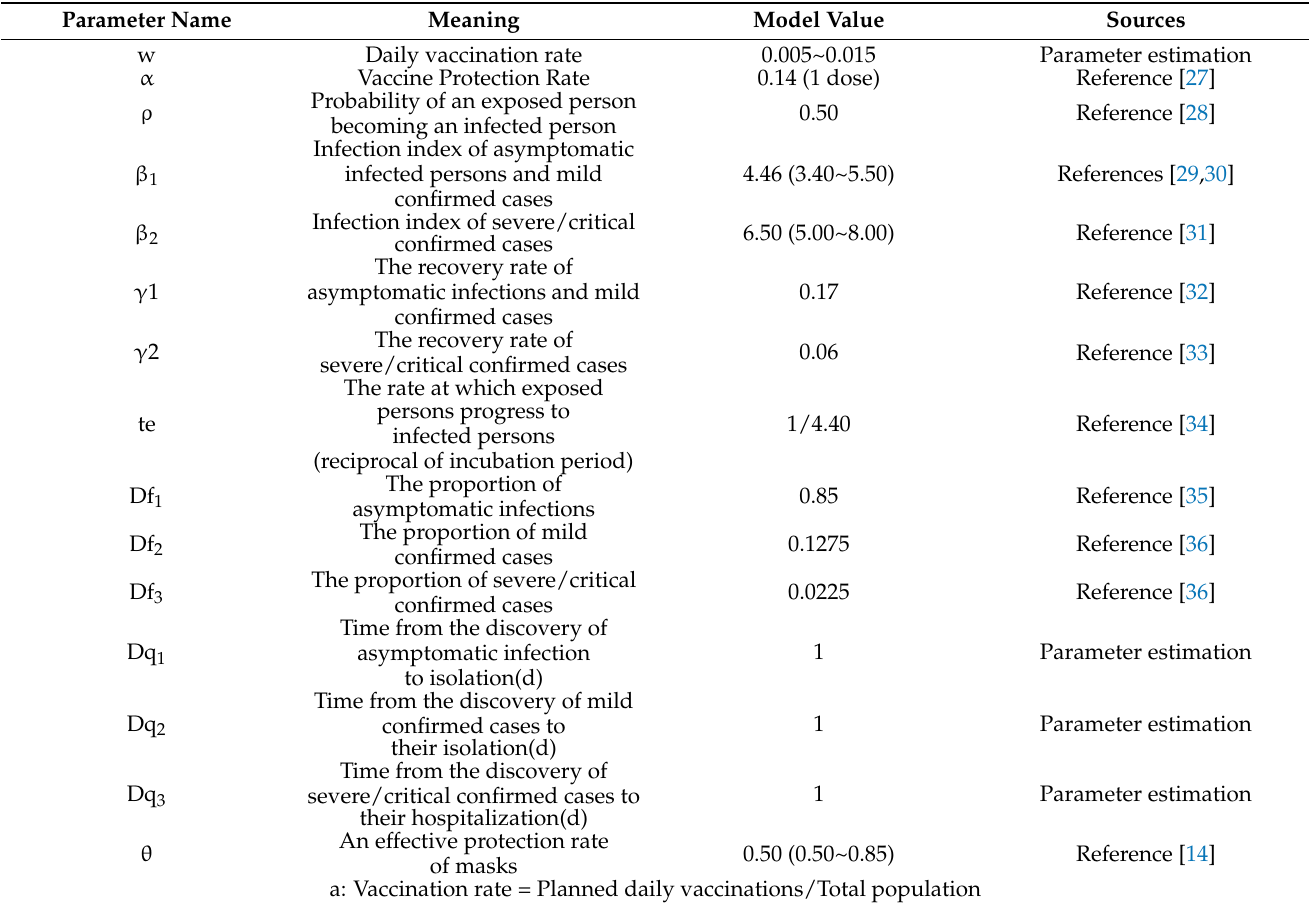
Table 1. SVEAI i QHR model parameter meaning and